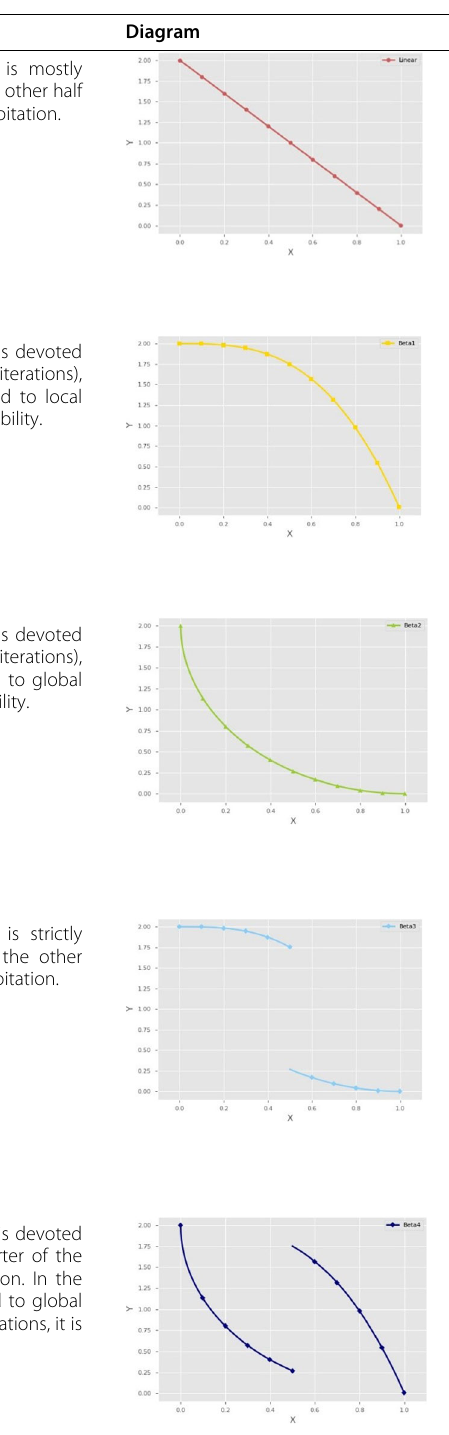
Table 5 Linear and non-linear